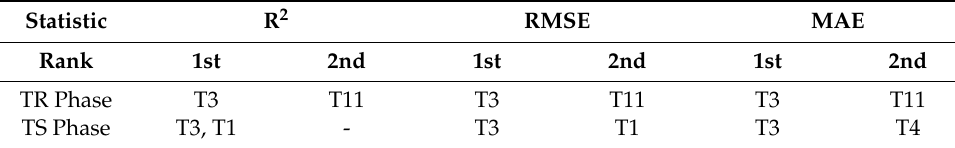
Figure 5. Effect of head size on the performance of models. ( a ) RMSE, ( b ) R 2 , ( c ) MAE. Table 4. Ranking of the GEP models (for 11 trials) based on R 2 and